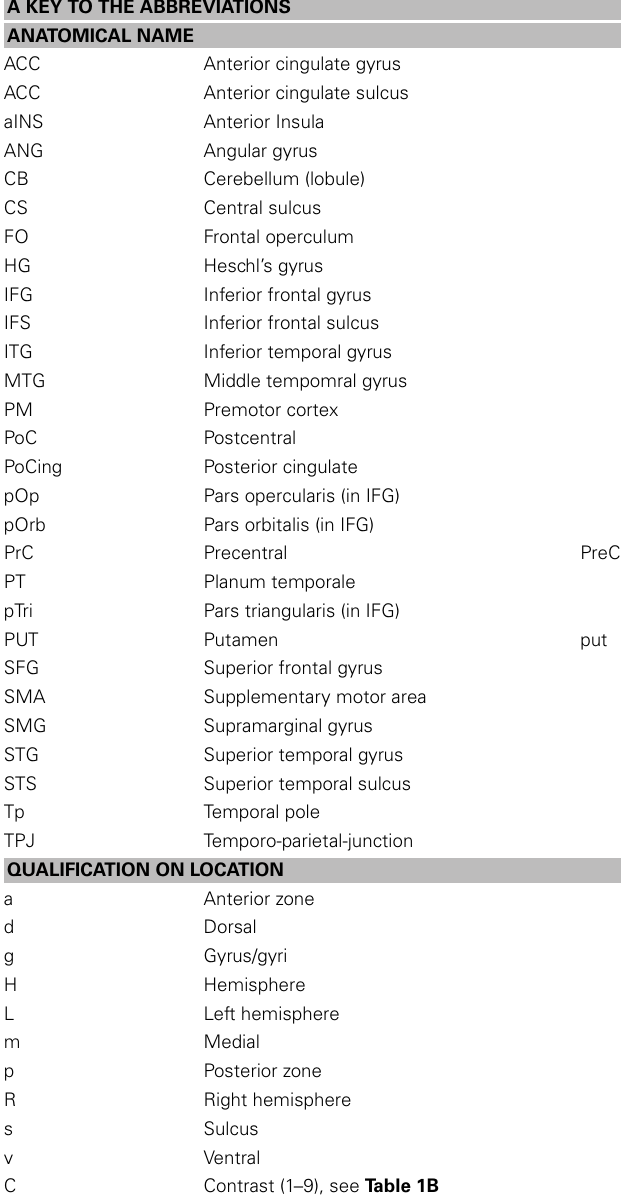
Table 4 | Abbreviations used in the text, tables, and